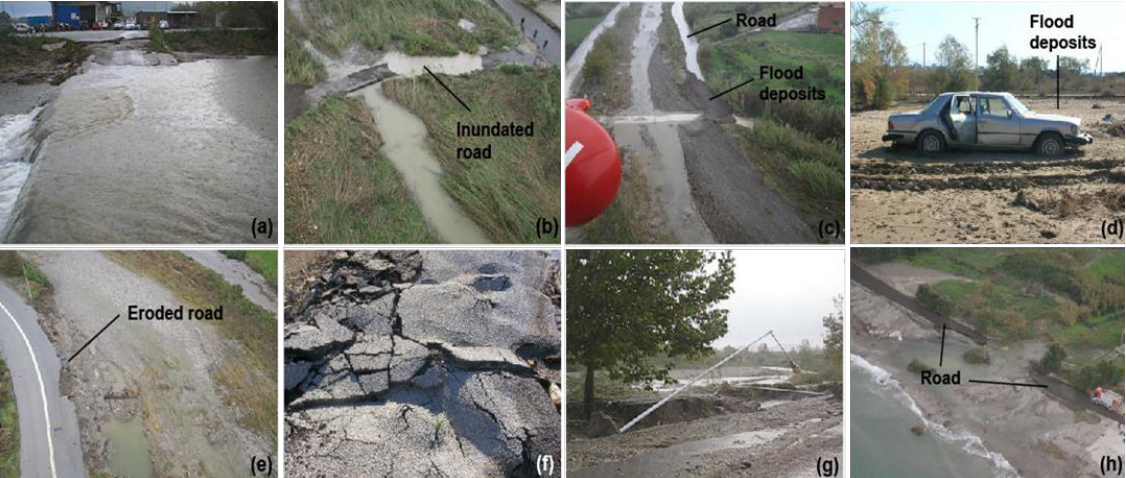
Figure 4. Effects of flash flooding caused by extreme precipitation events on the road network including: inundated parts (a, b), deposits of debris (c, d), eroded road fill and scoured roads (e), asphalt scouring (f), damages on road equipment (e.g. lighting installations) and (g) complete erosion and road collapse (h) Significant parts of the paved road network of the five study areas experienced the above effects during extreme precipitation events and the subsequent flooding (Figure 5). Results showed that: the length of roads that suffered both inundation and damages ranged between 0.4 and 9.7 km (1.6% - 5.1% of the total road length) depending on the basin the length of roads that experienced only inundation ranged between 3.5 and 16.2km (5.9% - 13.3% of the total road length) depending on the basin the length of roads that experienced either inundation or inundation and damages ranged between 3.9 and 25.9 km (8.2%-13.8% of the total road length) depending on the basin On average 2.9% of the total length of the road network of a basin experienced both inundation and damages and 11.5% experienced either inundation or inundation and damages. An average of 88.4% did not experience any effects (Figure